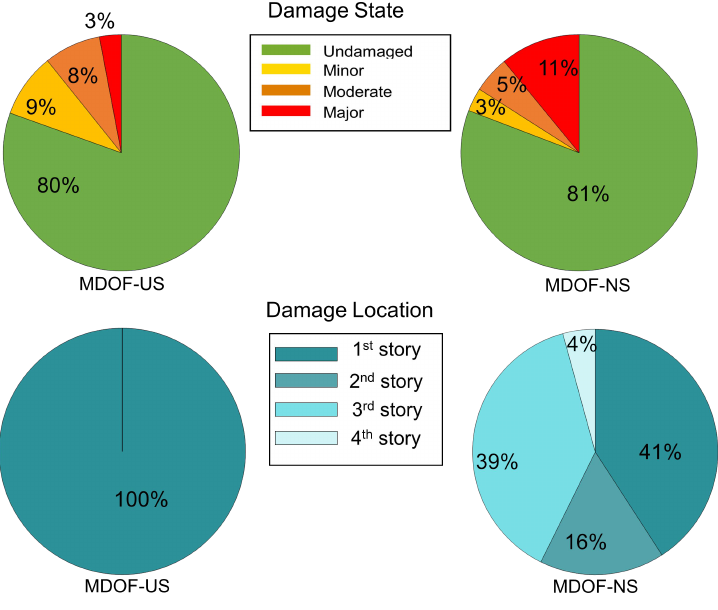
Figure 7. Worst damage state and location distribution of the MDOF-US and MDOF-NS